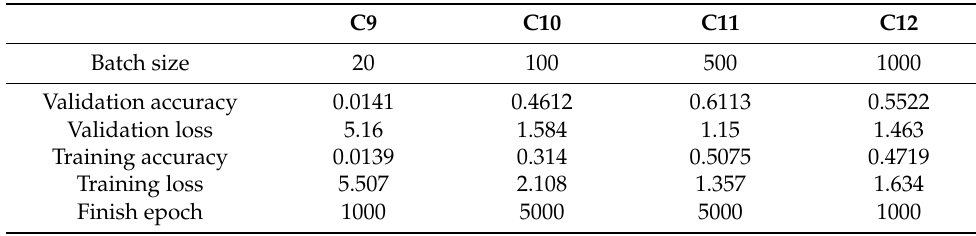
Table 5. Batch size